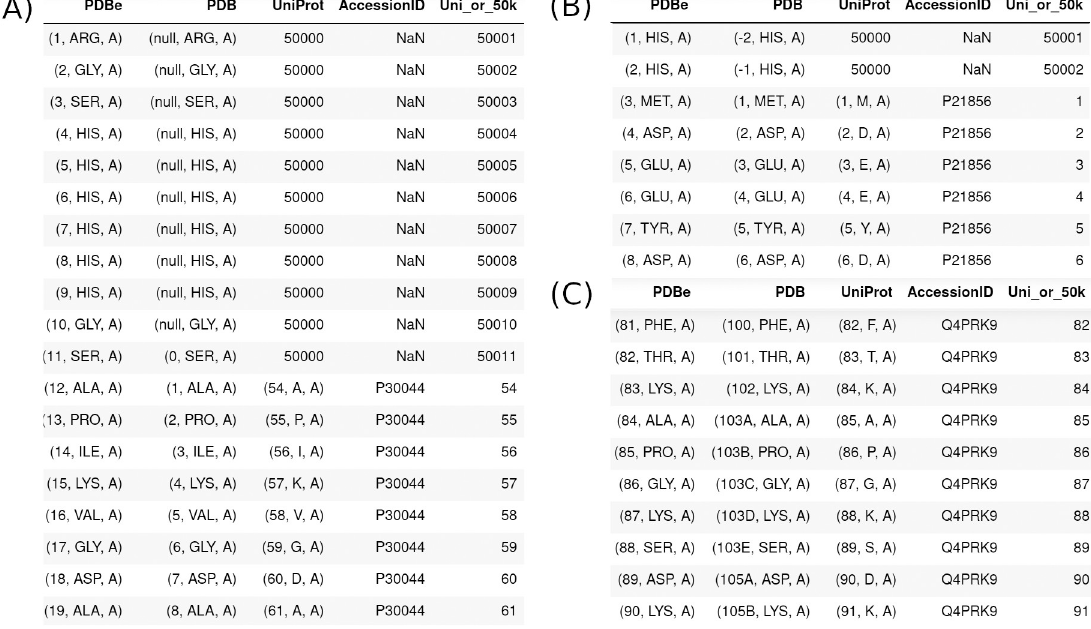
Fig 2. Small fragments of the Pandas dataframes assembled from SIFTS files: (A) 2vl3, (B) 2aa3, and (C) 1d5t. Entry 2vl3 contains a His tag that is not observed in the coordinates. Chain D of 2aa3 contains insertion codes (column 2) for some residues. Entry 1d5t contains a His tag with negative author residue numbers (column 2). The PDBe column in each image contains data for each amino acid in tuples (SeqResNum, ResName, and EntityId), where SeqResNum is the position of the amino acid in the sequence numbered from 1 to N (the length of the sequence). This field acts as the Pandas dataframe index for the whole table, since it is unique for each amino acid. The PDB column contains tuples (AuthResNum + InsCode, ResName, and ChainID). The UniProt column contain tuples of (UniProtResNum, UniProtResName, ChainID) and if there is no UniProt residue number, it contains the number “50,000”. The next column contains the UniProt AccessionID. The column UniProt_50k provides the final numbering of residues in the PDBrenum output file: it is the UniProt number when it is available, and 50,000+SeqResNum when there is no UniProt for a chain that has a UniProt. Chains with no UniProt in SIFTS are not renumbered.